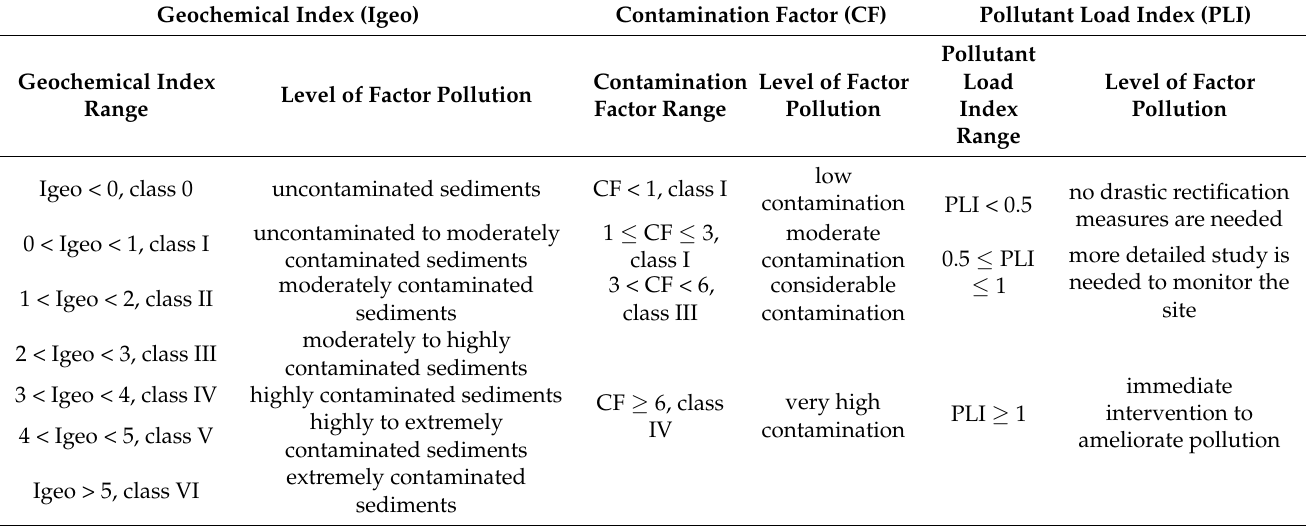
Table 3. Range index and level of factor pollution for Igeo [25], CF [26], and PLI